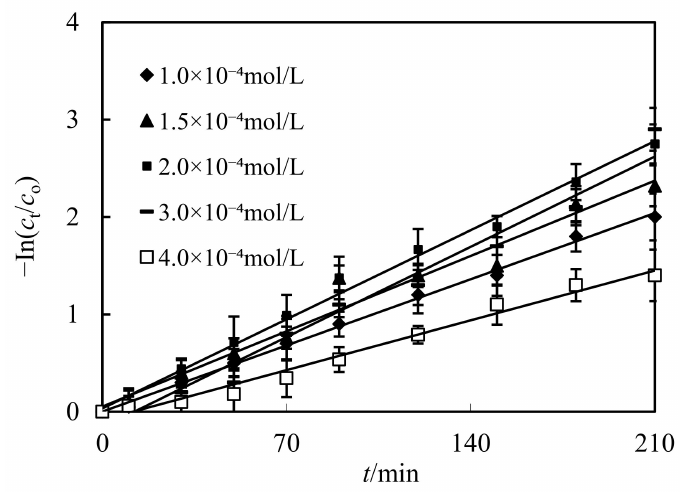
Figure 7. Impact of initial molarities of Cd(II) on dislodging of Cd(II).